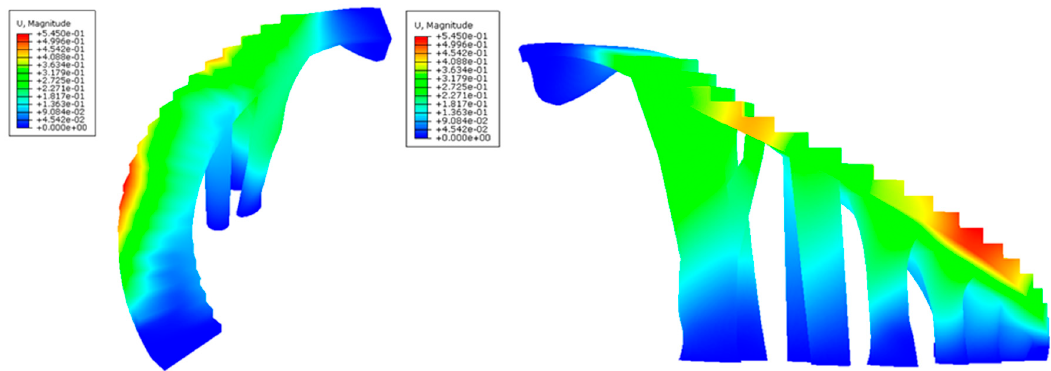
Figure 27. Field of displacements (mm) obtained in the mechanical simulations: the BIM building element E 1 indicated in two perspectives in the left and right pictures. Polymers 2019 , 11 , x FOR PEER REVIEW 20 of 29